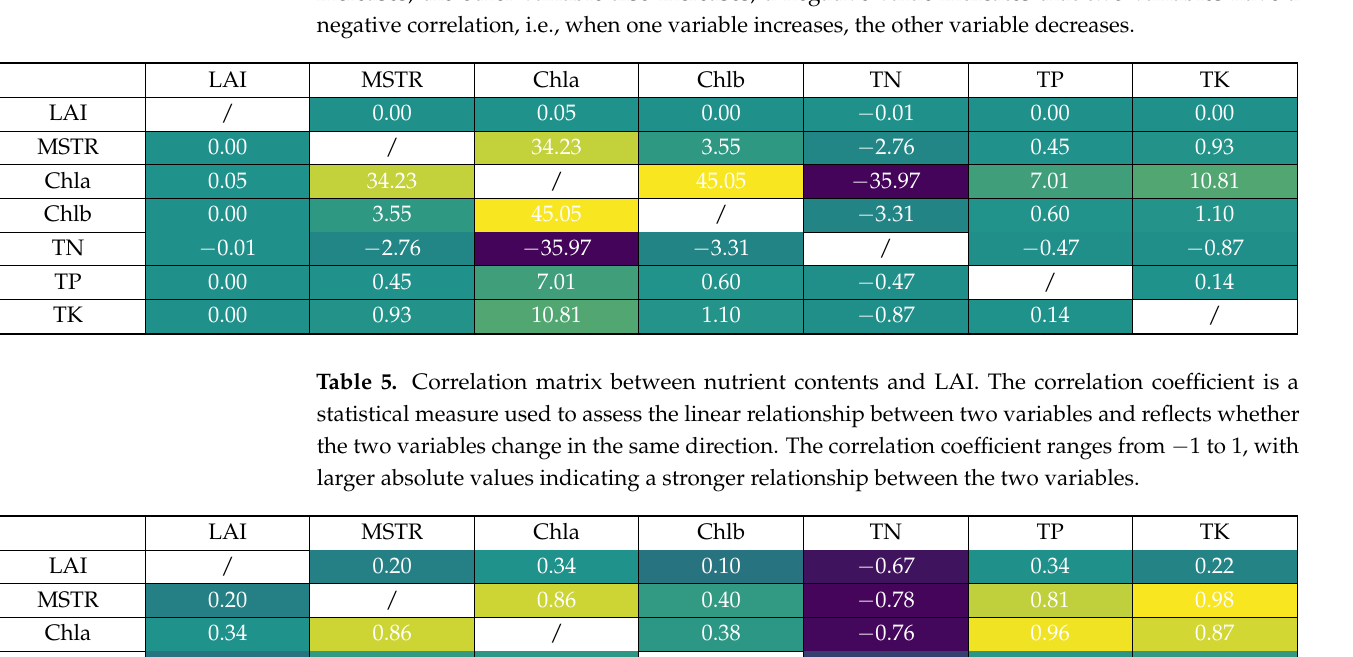
Table 4. Covariance matrix of nutrient contents and LAI. The covariance can be positive or negative. A positive value indicates that two variables have a positive correlation, i.e., when one variable increases, the other variable also increases; a negative value indicates that two variables have a negative correlation, i.e., when one variable increases, the other variable decreases.